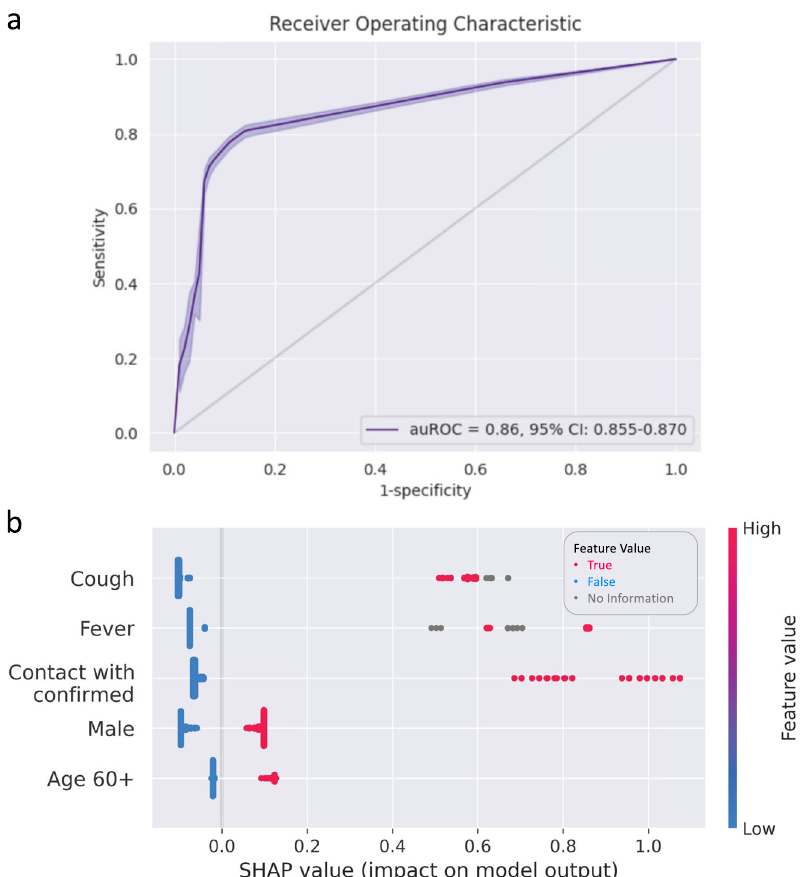
Fig. 3 Performance using only balanced features. a ROC curve and b SHAP beeswarm plot for the prospective test set through training, using only balanced features.